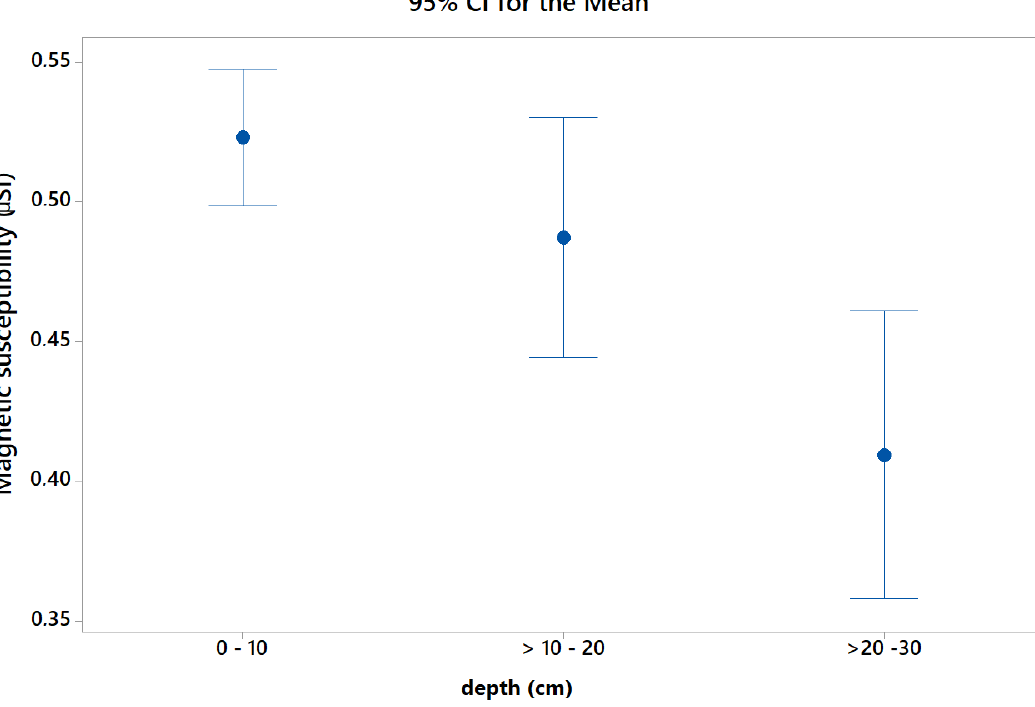
Table 6. Mean value, standard deviation, and confidence interval per sample depth.